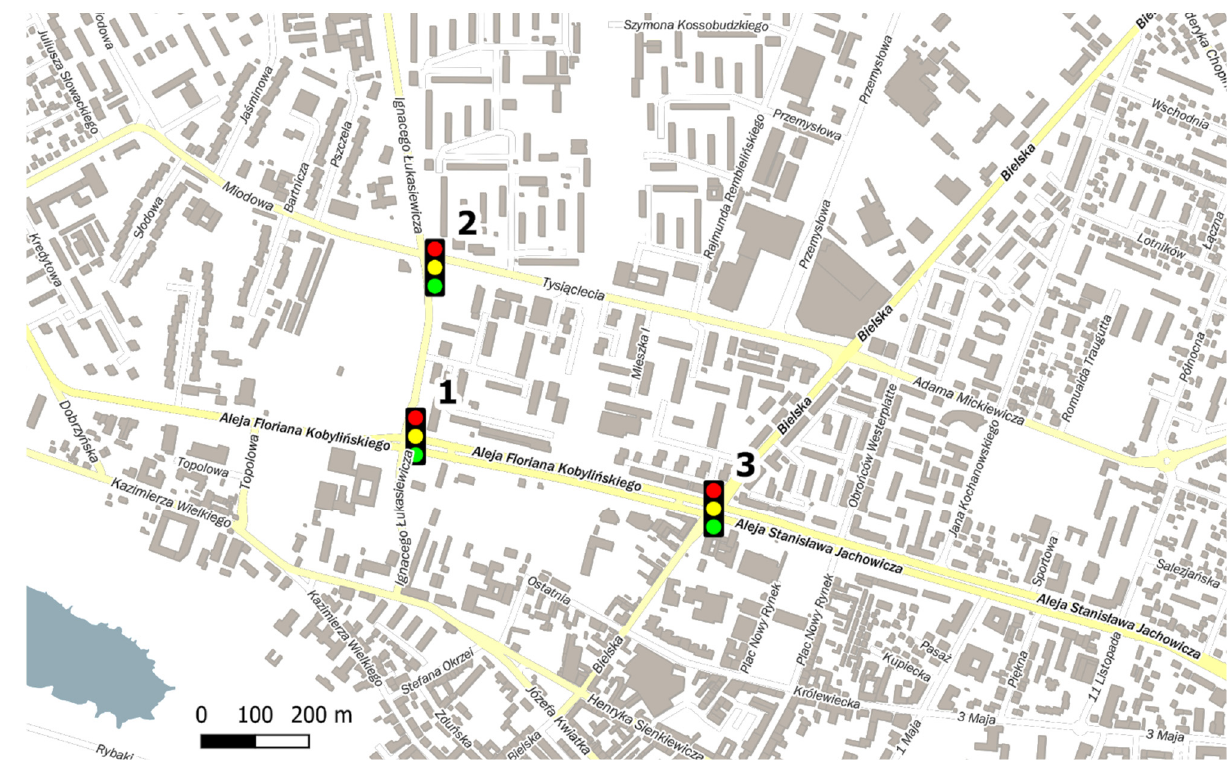
Figure 2. Location of measurement objects in the city of P ł ock. (Background map © OpenStreetMap contributors, [87]).